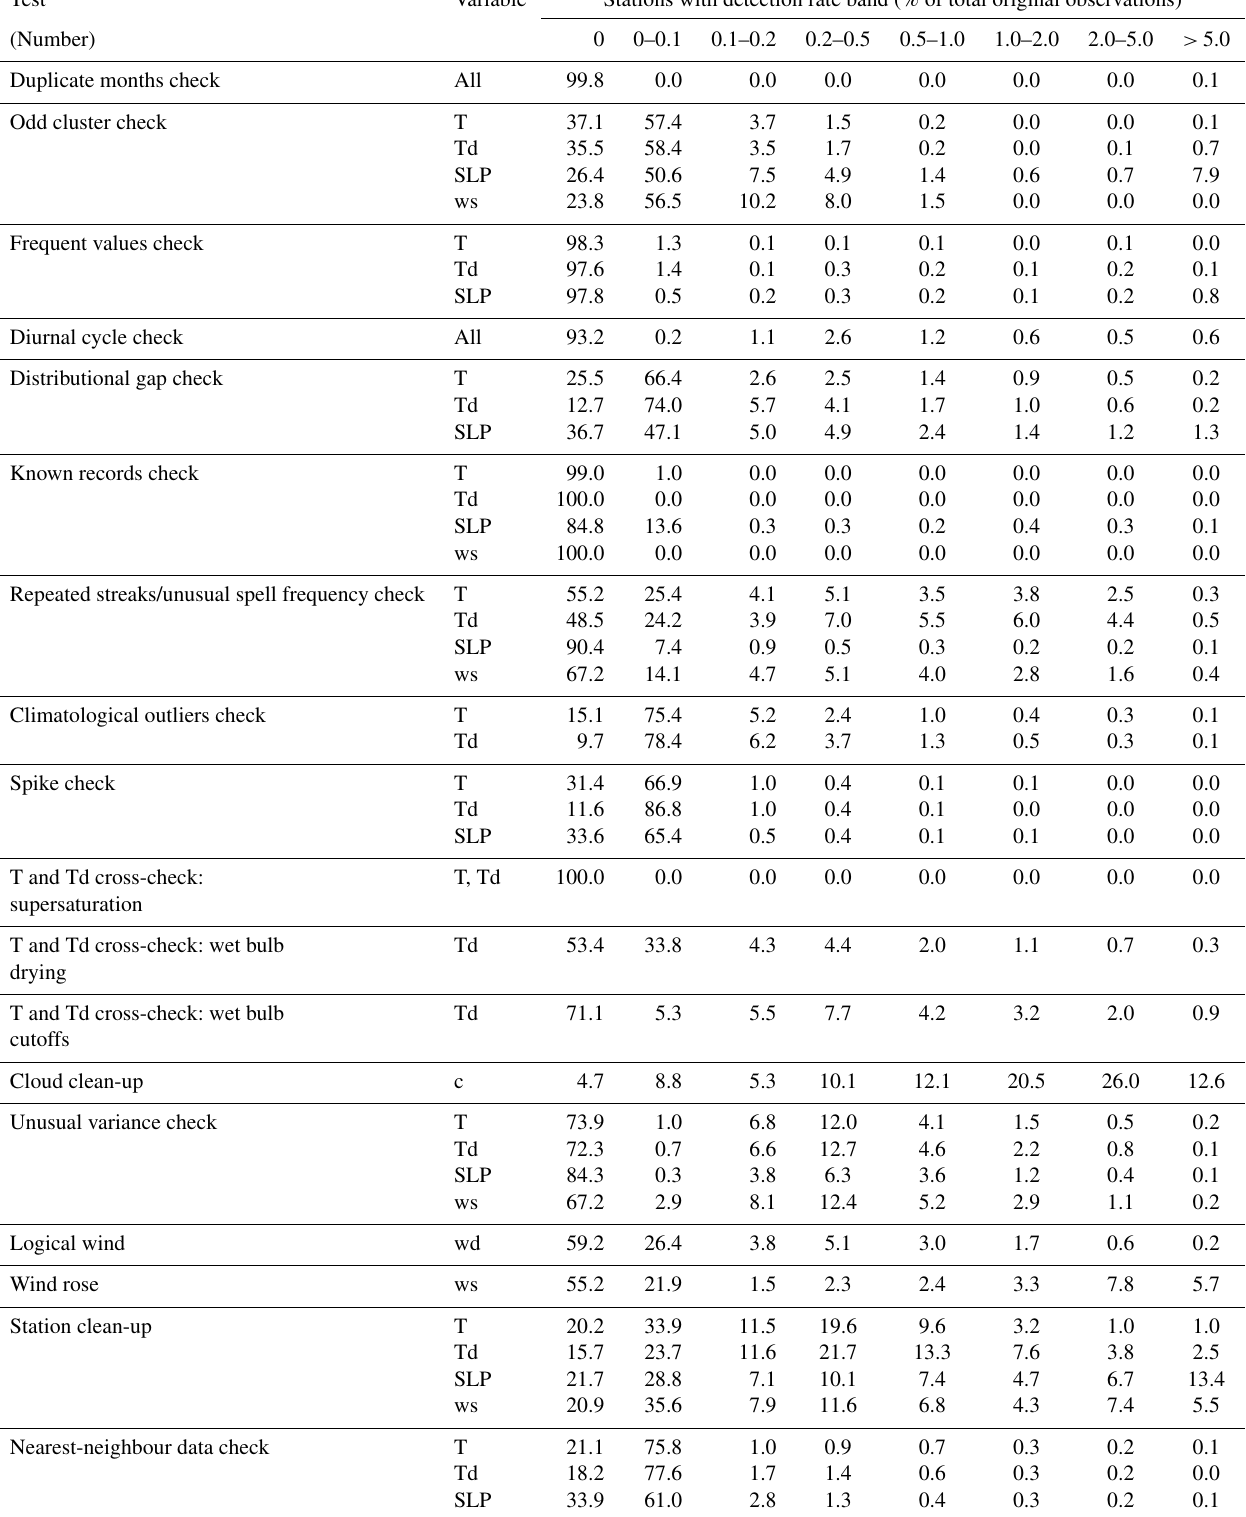
Table A2. As Table 3 but in %. As a result of rounding, rows may not sum to exactly